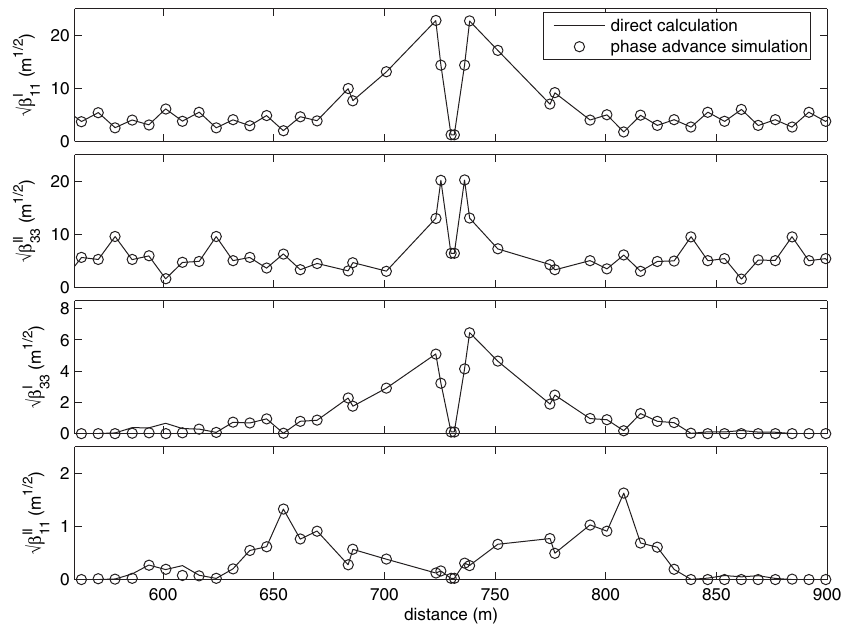
FIG. 3. Calculation of lattice functions from simulated phase-advance data in the PEP-II